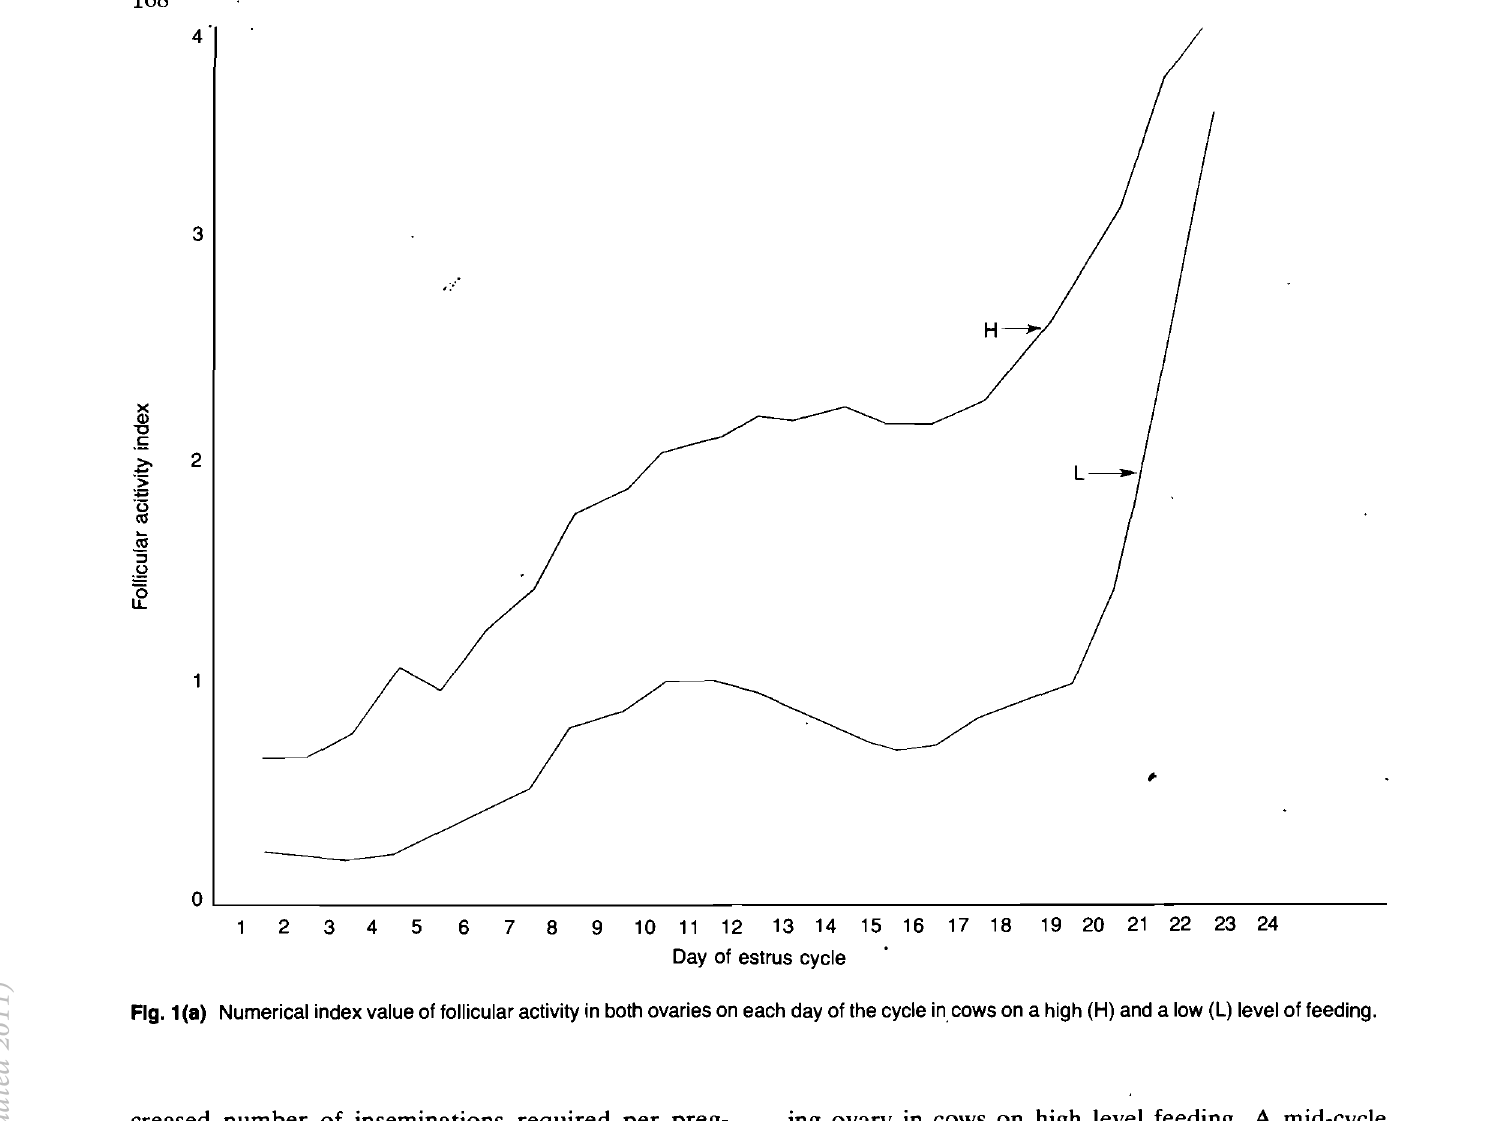
Fig. 1 (8) Numerical index value of follicular activity in both ovaries on each day of the cycle in cows on a high (H) and a low (L) level of feeding.